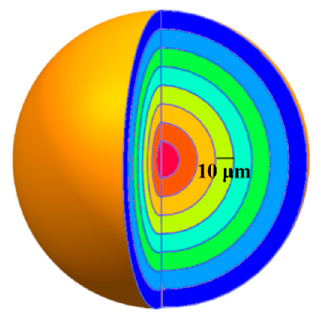
Figure 7. A schematic diagram of the pore space distribution.